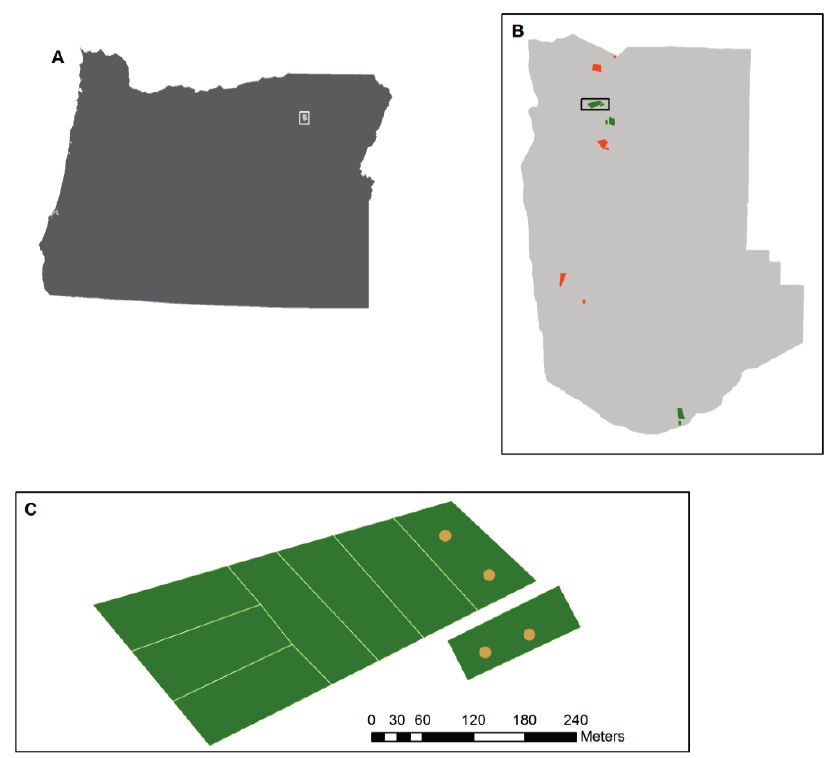
Figure 2. The study area where TLS scans were obtained. ( A ) shows the state of Oregon with the extent of ( B ) enclosed by the white box. ( B ) shows the Starkey Experimental Forest and Range. Red polygons are thinned and burned blocks, and green polygons are untreated blocks. The black rectangle is the extent of ( C ), which shows the experimental design for an untreated block. Scans were collected at locations represented by yellow dots. The dots within one of the six contiguous rectangles are in the ungrazed plot, while the grazed plot is the unattached